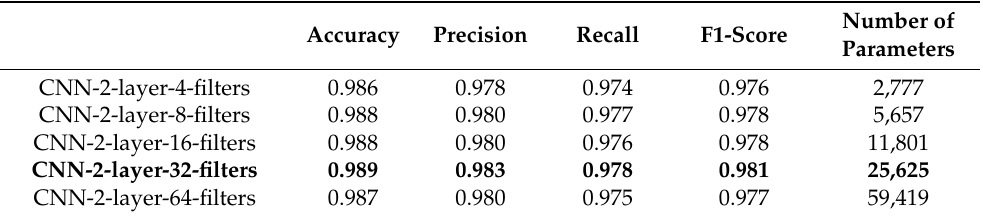
Table 6. Results from a 2-layer CNN model obtained by varying the number of filters, with length of filters = 4 in both convolutional